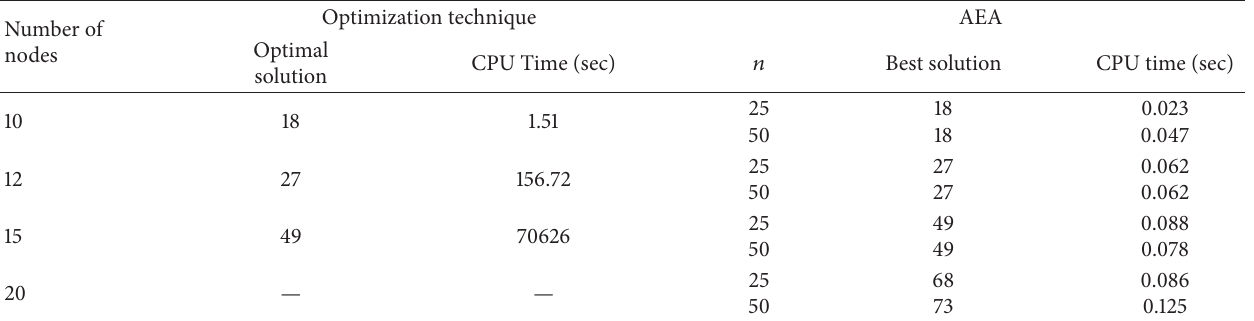
Table 3: The performance experiment result